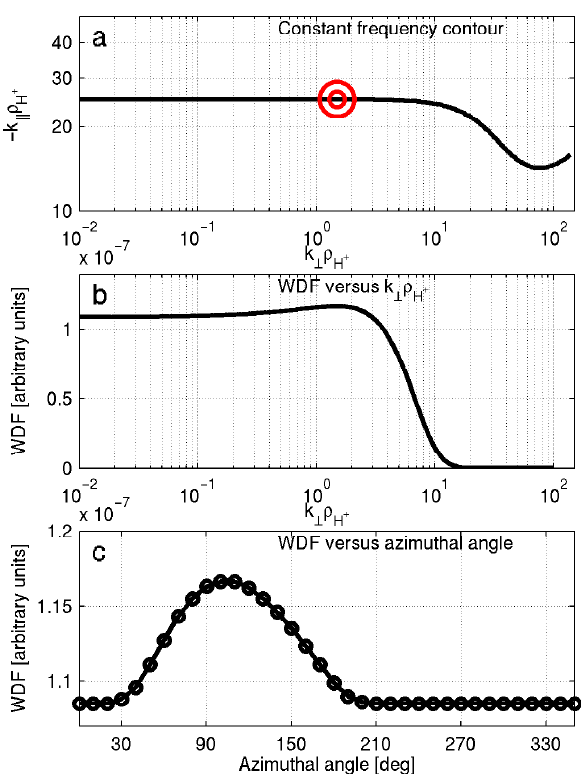
Fig. 8. (a) Constant frequency contour for the whistler mode at 100Hz in k -space. The wave vectors are normalized to the gyrora- dius of the 2keV protons in the model, that is, ρ H + =208km. The parallel wave vectors are negative, which correspond to propagation anti-parallel to B 0 . The peak of the reconstructed WDF is indicated.